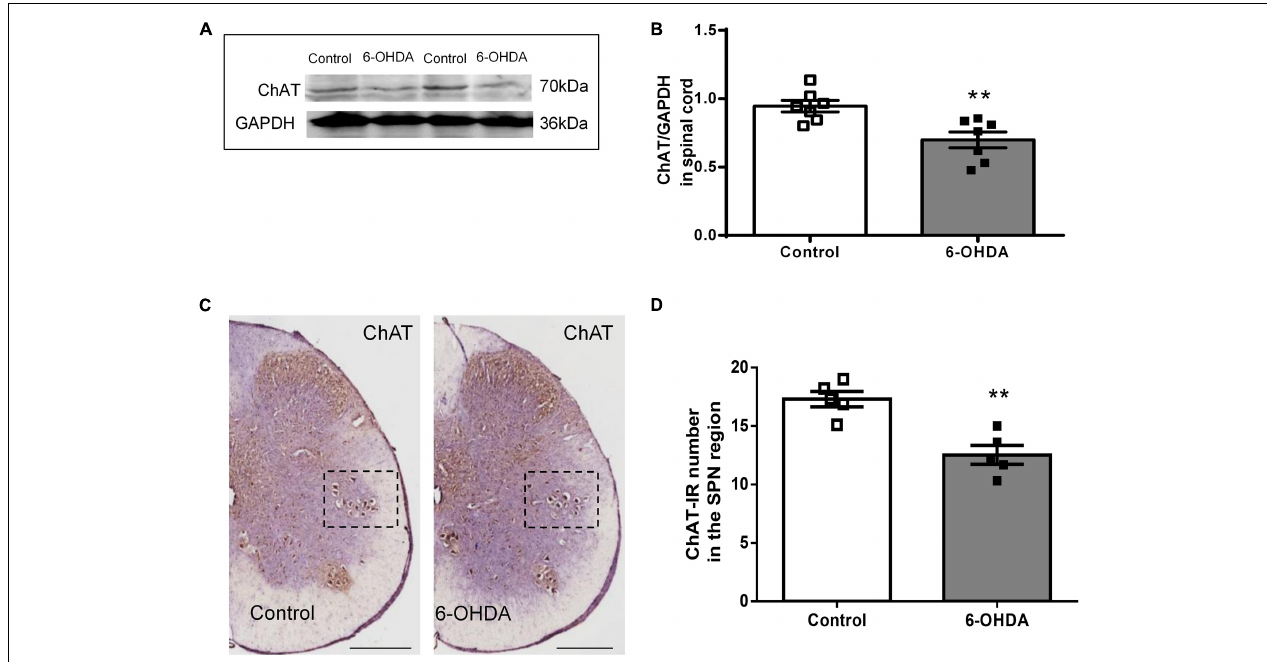
FIGURE 5 | Expression of choline acetyltransferase (ChAT) in the sacral parasympathetic nuclei (SPN). (A,B) Representative Western blot and bar charts show the levels of the ChAT protein in the L6-S1 spinal segment tissue ( n = 7). GAPDH was used as an internal control. (C) The expression of ChAT in the SPN region (black frame). Scale bar, 500 µ m. (D) The ChAT-IR number in the SPN region ( n = 5). ** P < 0.01.